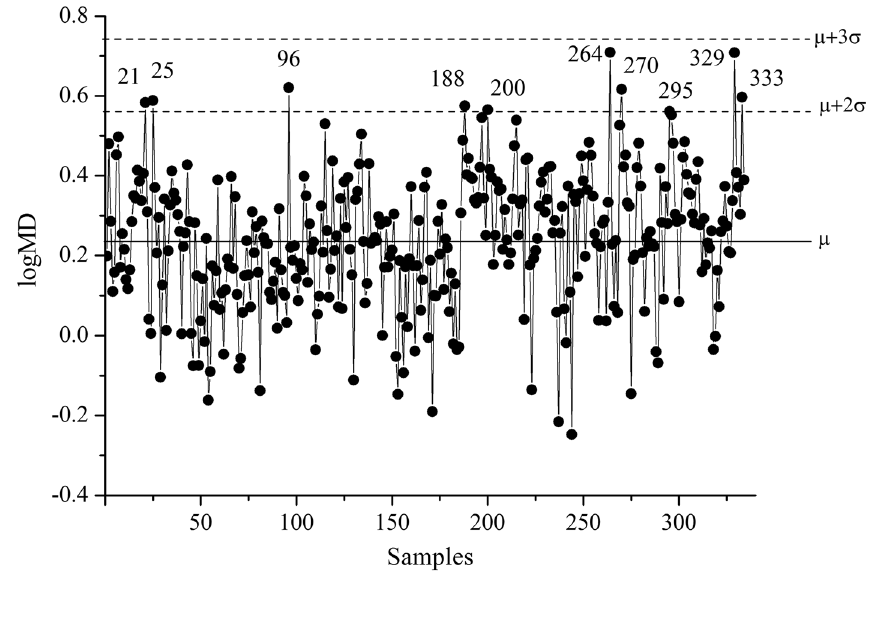
Fig. 3 Charts of 4 main prin- cipal components. Outliers are marked by